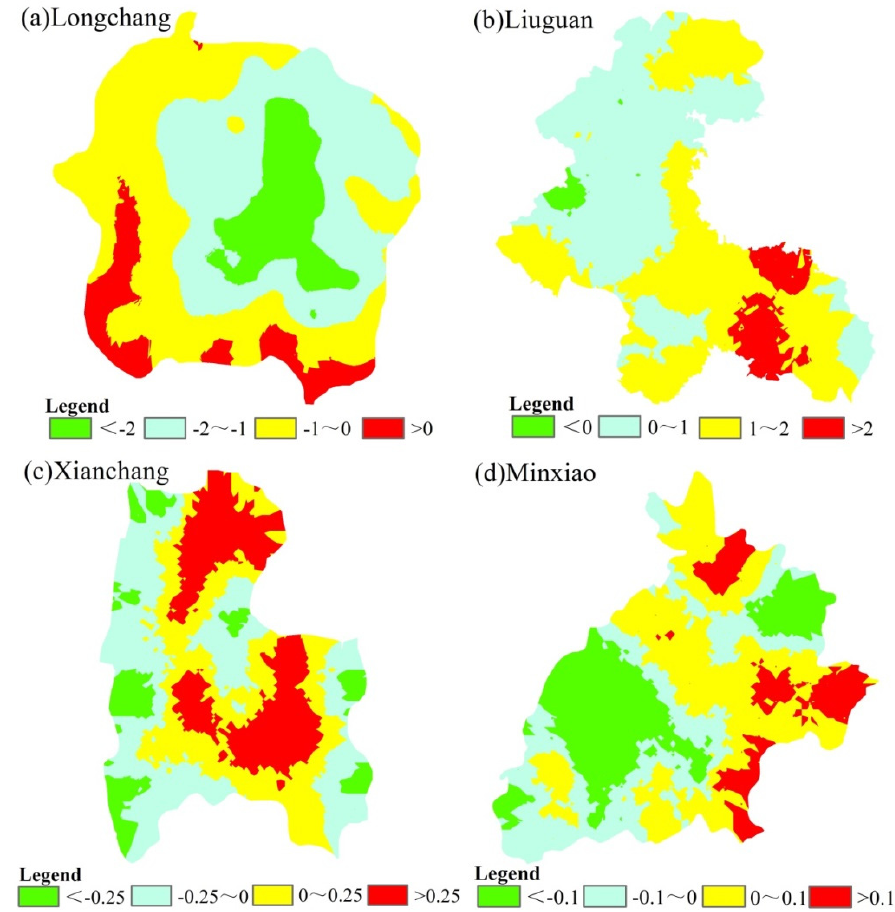
Figure 4. The spatial patterns of changes in landscape ecological risk from 2010 to 2020. ( a ) Longchang, ( b ) Liuguan, ( c ) Xianchang, ( d ) Minxiao.